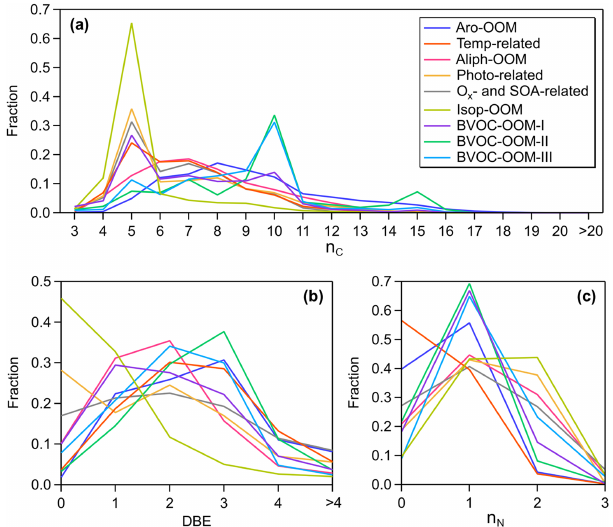
Figure 2. The distributions of observed non-nitro OOMs grouped by (a) the number of carbon atoms ( n C ), (b) DBE, and (c) the num- ber of nitrogen atoms ( n N ) in nine factors. Since the signals of RO 2 are very weak, RO 2 from BVOC-OOM-I and BVOC-OOM-II are excluded in (b) to keep the integer value of